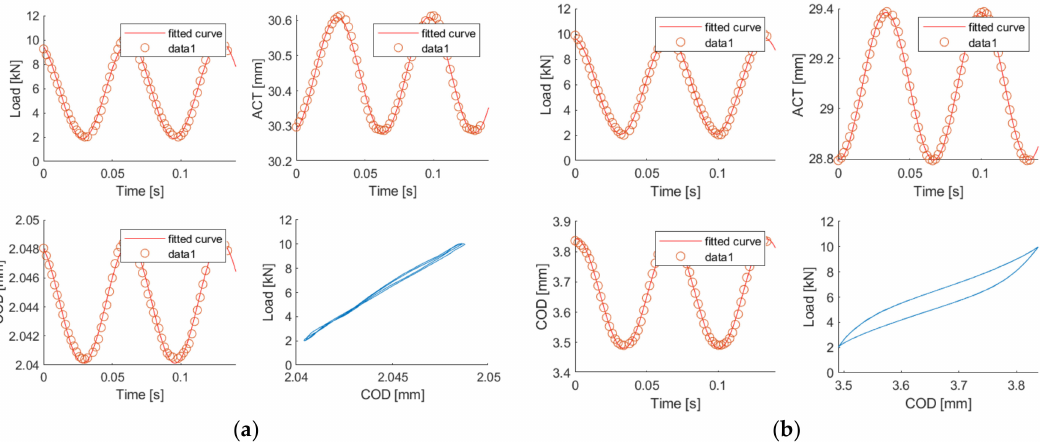
Figure 13. Comparison of the specimen response during the fatigue test. In an uncracked specimen ( a ). In a cracked specimen ( b